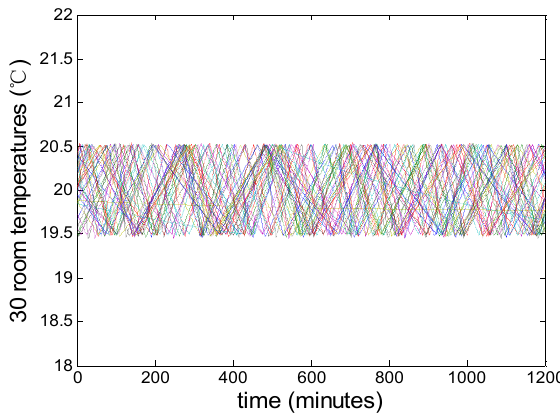
Figure 10. Total power demand of the whole AC population.